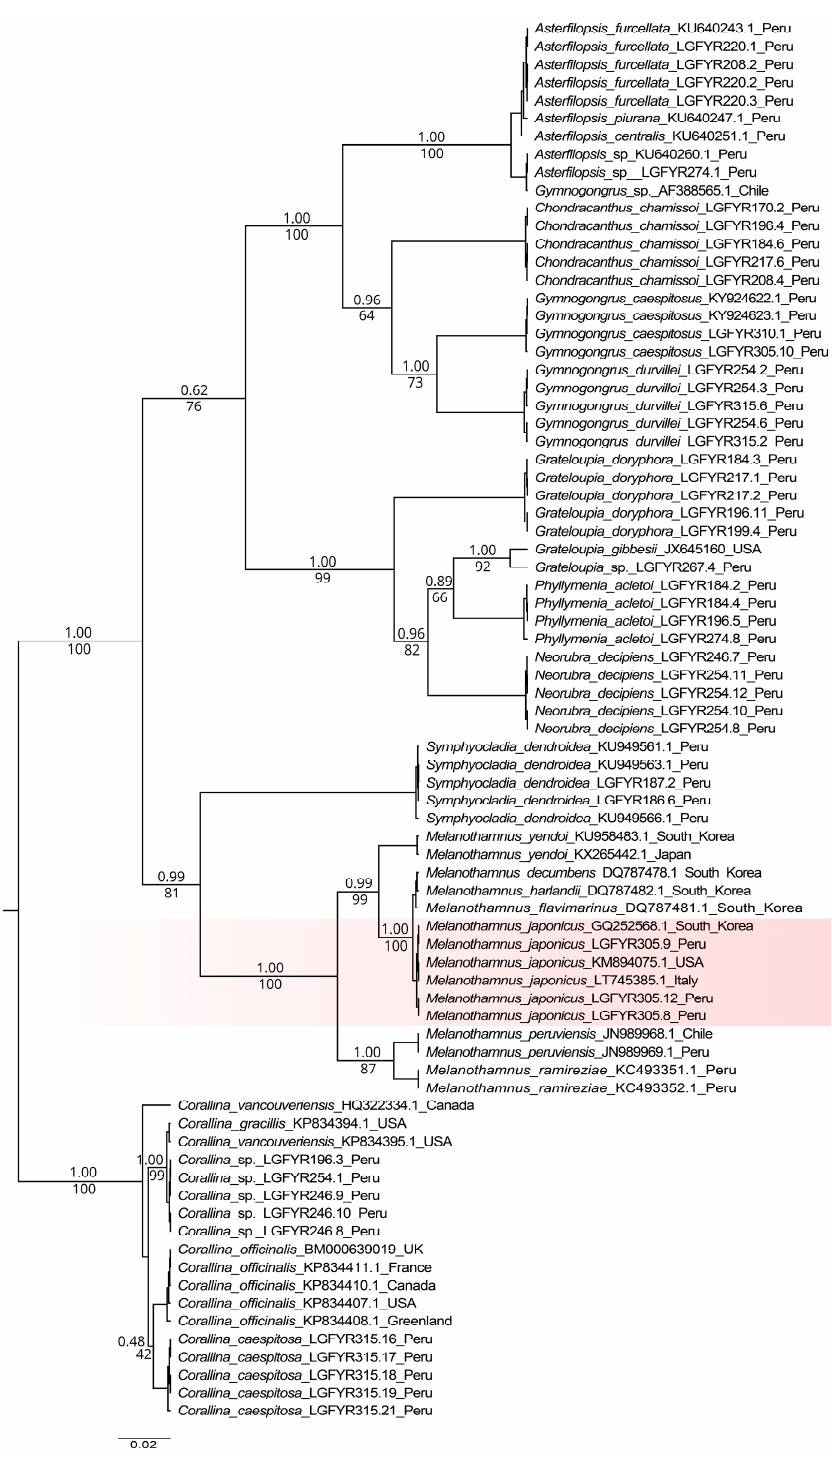
Figure 2. Bayesian inference tree of Florideophyceae species from Peru. The Bayesian inference analysis was performed for 50,000,000 generations using ribulose-1,5-bisphosphate carboxylase/oxygenase large subunit ( rbc L-5P) sequences of Florideophyceae species collected along the coast of Ancash, Peru, and phylogenetically close species with available rbc L-5P sequences. The phylogenetic tree shows the sequences of Melanothamnus japonicus from Peru, the USA, and Italy in a strongly supported clade with sequences of Melanothamnus species native to Japan and South Korea, the native range of this species. The clade containing M. japonicus is shown in red. Bayesian posterior probability (BPP) and maximum likelihood bootstrap (MLB) values are indicated above and below the branches, respectively.